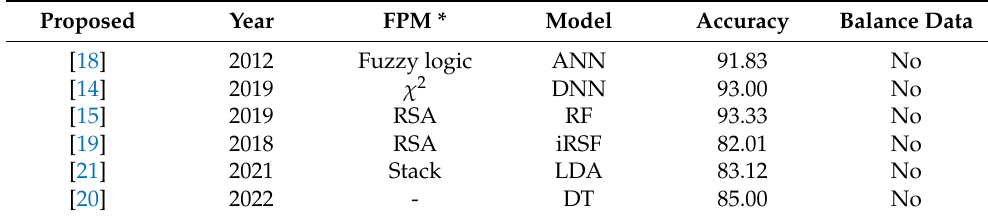
Table 1. Summary of previously proposed